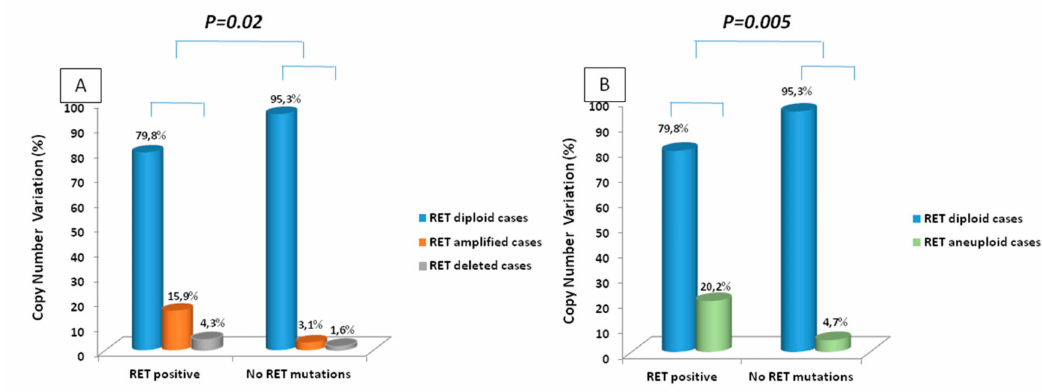
Figure 3. Comparison between the RET somatic mutation profile and the status of RET ploidy. ( A ) amplified and deleted cases are considered separately; ( B ) RET deleted and amplified cases (i.e., aneuploid cases) have been considered as a single category. To verify if there was a specific correlation with the type of RET mutation and RET gen CNV we classified our